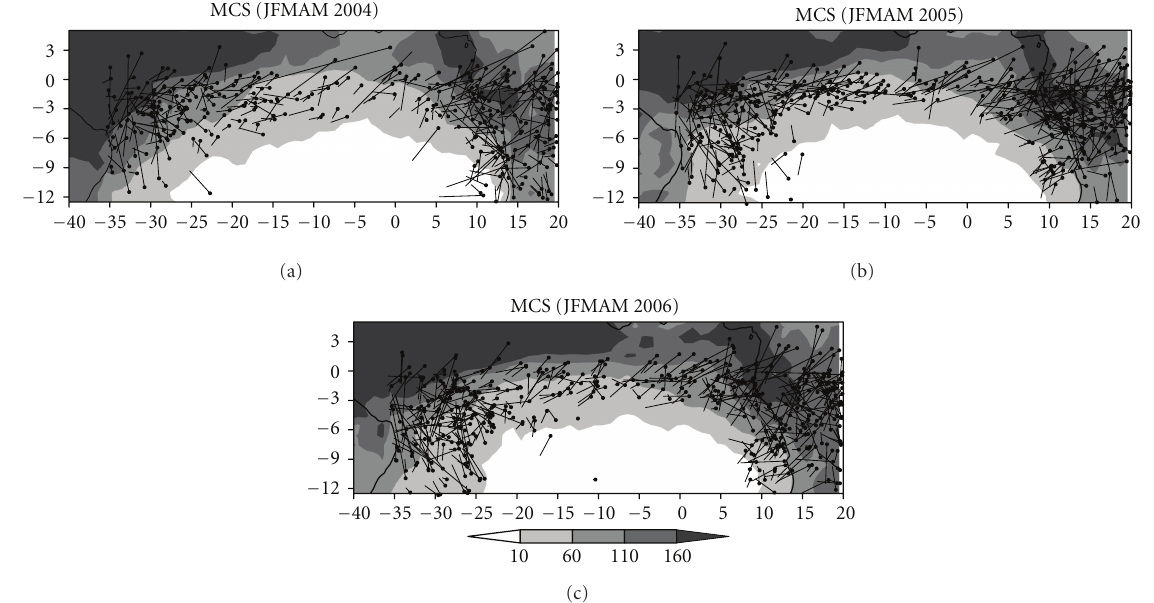
Figure 2: MCSs (lifespan > 10 hours) that moved westward in the area 5 ◦ N–12.5 ◦ S, 35 ◦ W–20 ◦ E during January–May in (a) 2004, (b) 2005, and (c) 2006 are depicted by straight lines linking onset (black dots) and dissipation coordinates. Shaded contours represent seasonally average of the monthly precipitations (mm · month − 1 ) in